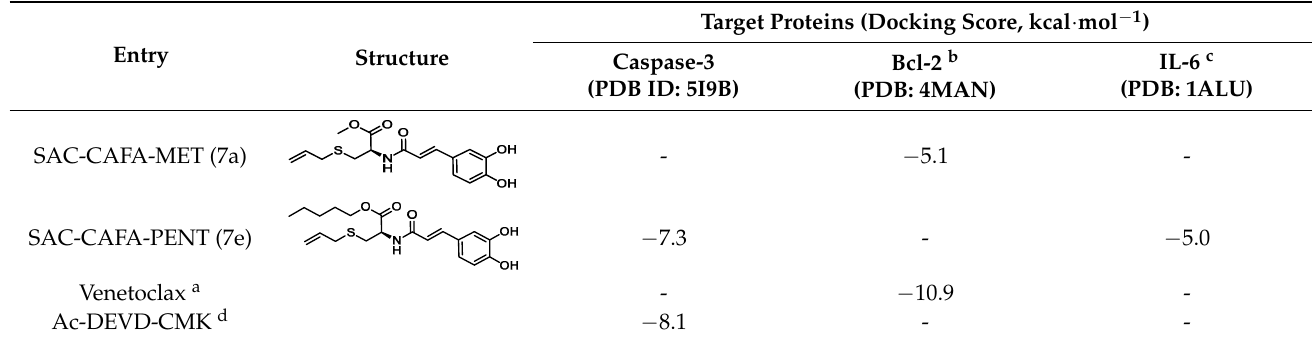
Table 1. Best binding energy (kcal · mol − 1 ) based on AutoDock scoring of the hybrids.